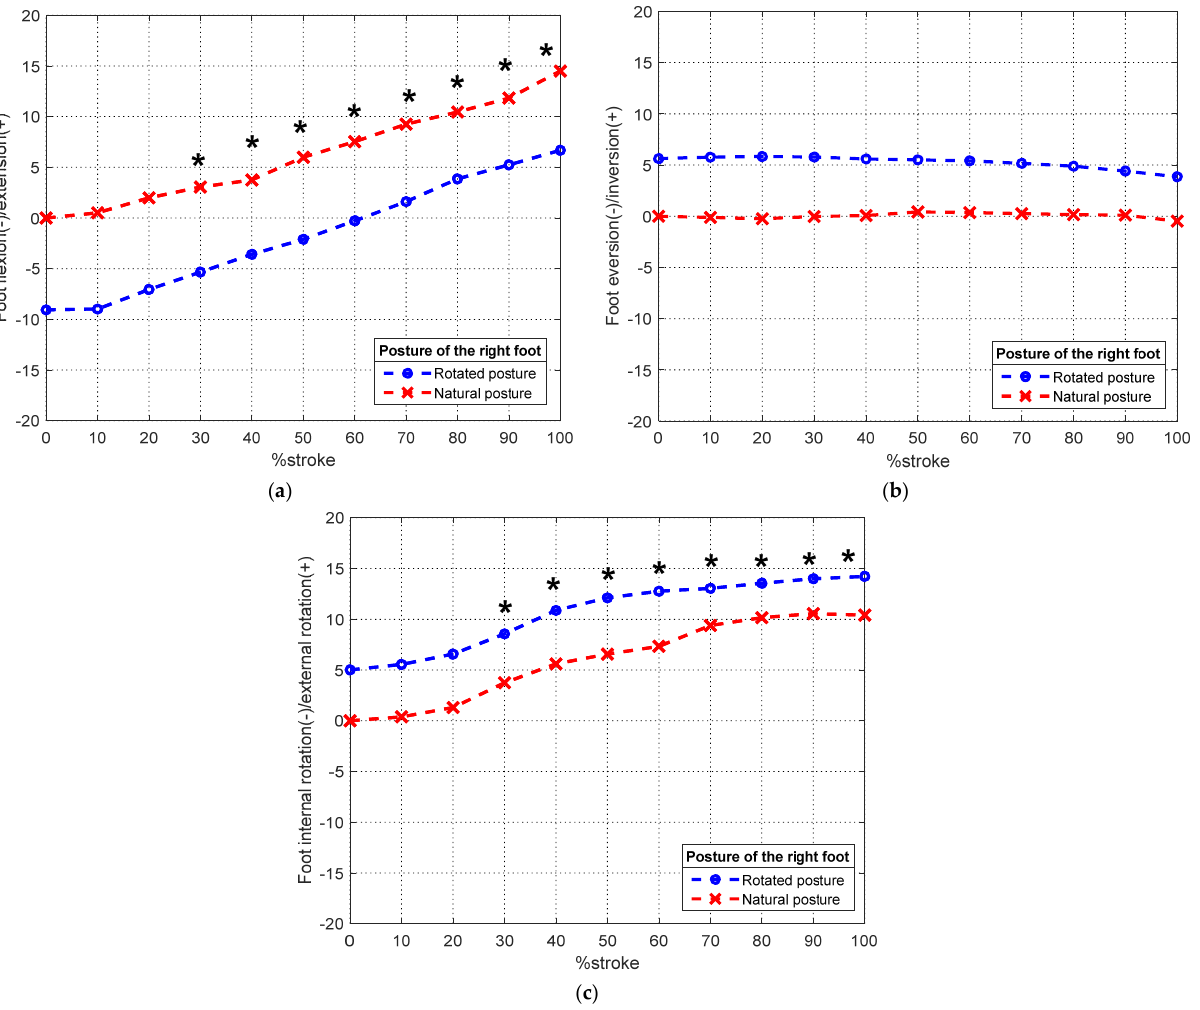
Figure 9. Foot angles (unit: °) while operating the accelerator for rotated and natural postures (the angles were normalized with average angle for the natural posture at 0% of stroke; symbol * represents statistical significance at a significance level of 0.05 against the initial stroke). ( a ) foot flexion and extension (foot posture: p < 0.001; %stroke: p < 0.001); ( b ) foot eversion and inversion (foot posture: p < 0.001; %stroke: p = 0.27); ( c ) foot internal and external rotations (foot posture: p < 0.001; %stroke: p < 0.001)